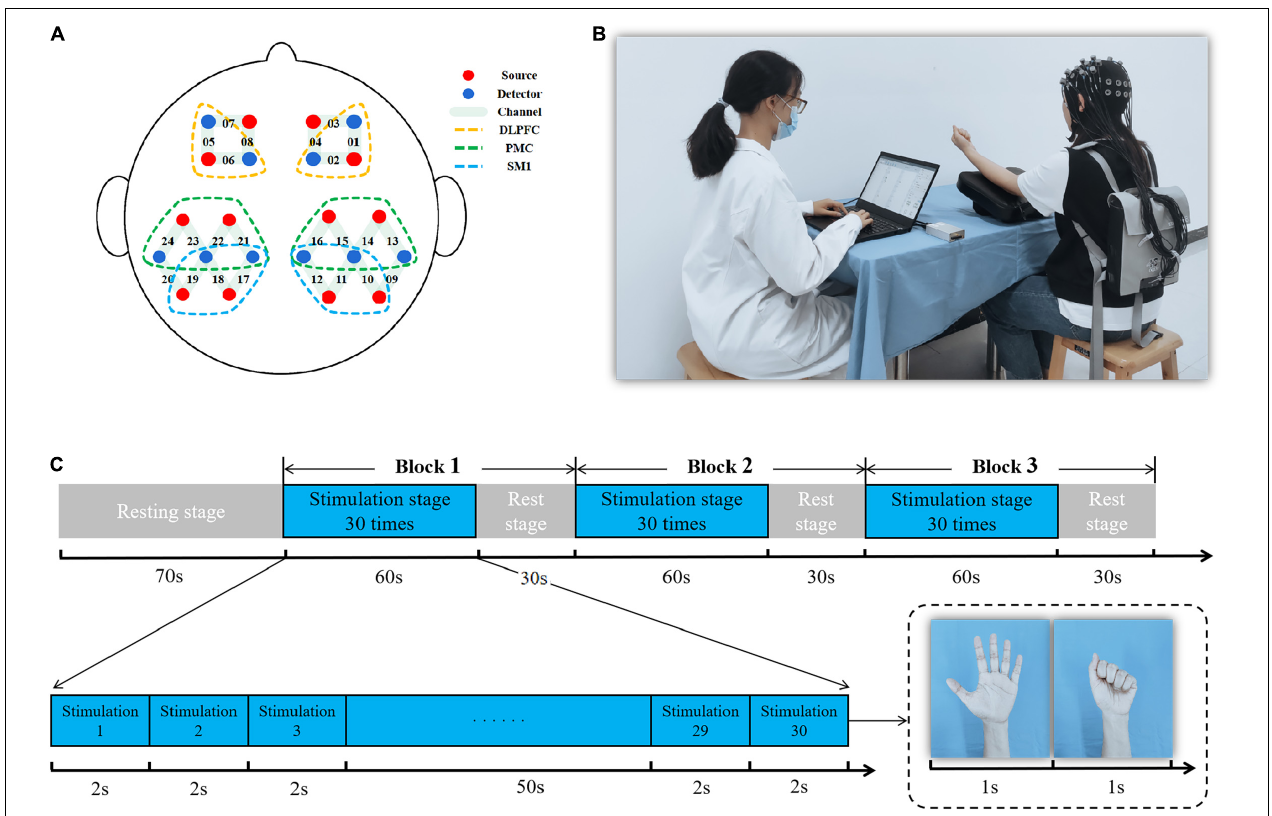
FIGURE 3 | Diagram of the functional near-infrared spectroscopy (fNIRS) measurement. (A) Regions of interest and the channel setting; (B) fNIRS measurement presentation; (C) fNIRS experimental